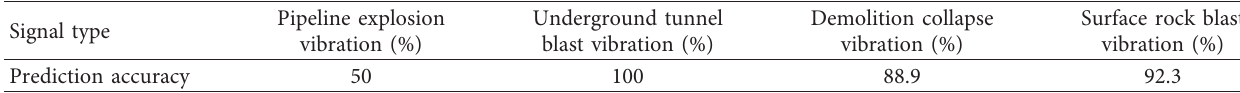
Table 6: Prediction result statistics.